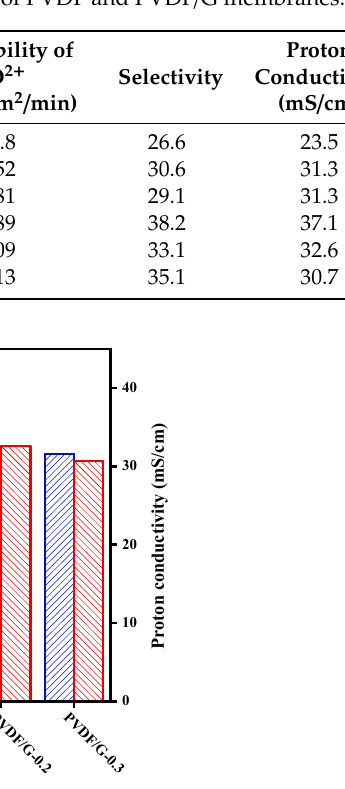
Figure 5. Ion selectivity and proton conductivity of PVDF and PVDF/G membranes.